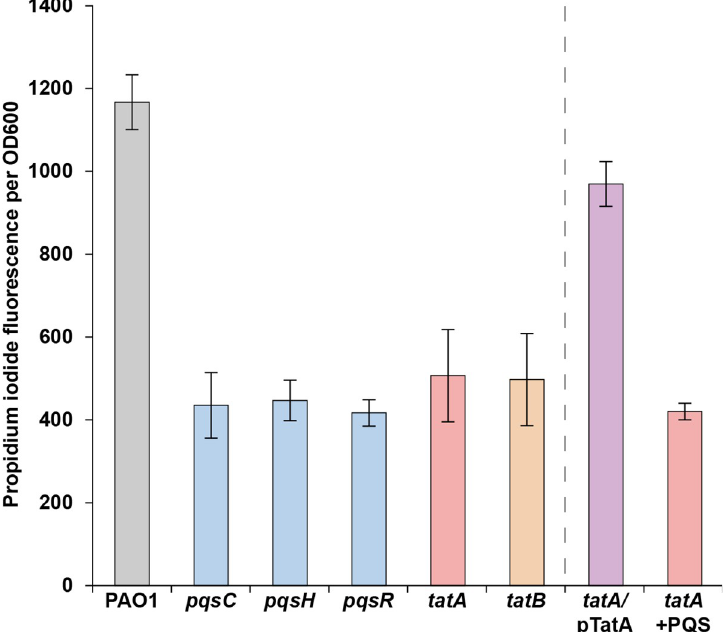
Fig 2. Transposon mutant screen for P . aeruginosa strains defective for eDNA release. P . aeruginosa wild-type and mutant strains were grown for 24 h in 96 well microtiter plates containing ABTG medium, after which the relative levels of eDNA in the cultures were determined using a PI binding assay. The means and standard deviations of eight replicates are shown.